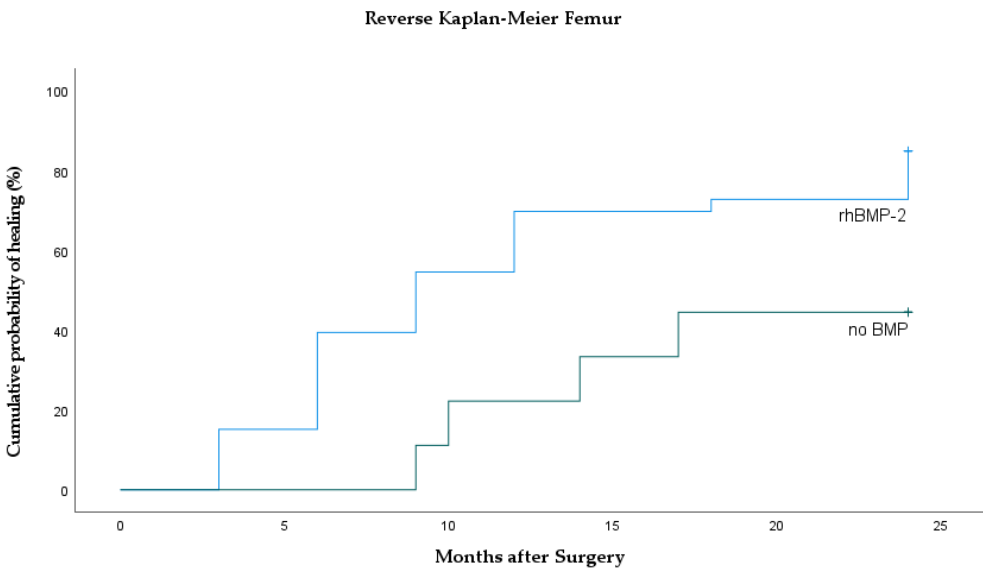
Figure 4. Reverse Kaplan–Meier curves of the femur showing cumulative incidence of bone healing separately for rhBMP-2 and control (no BMP).